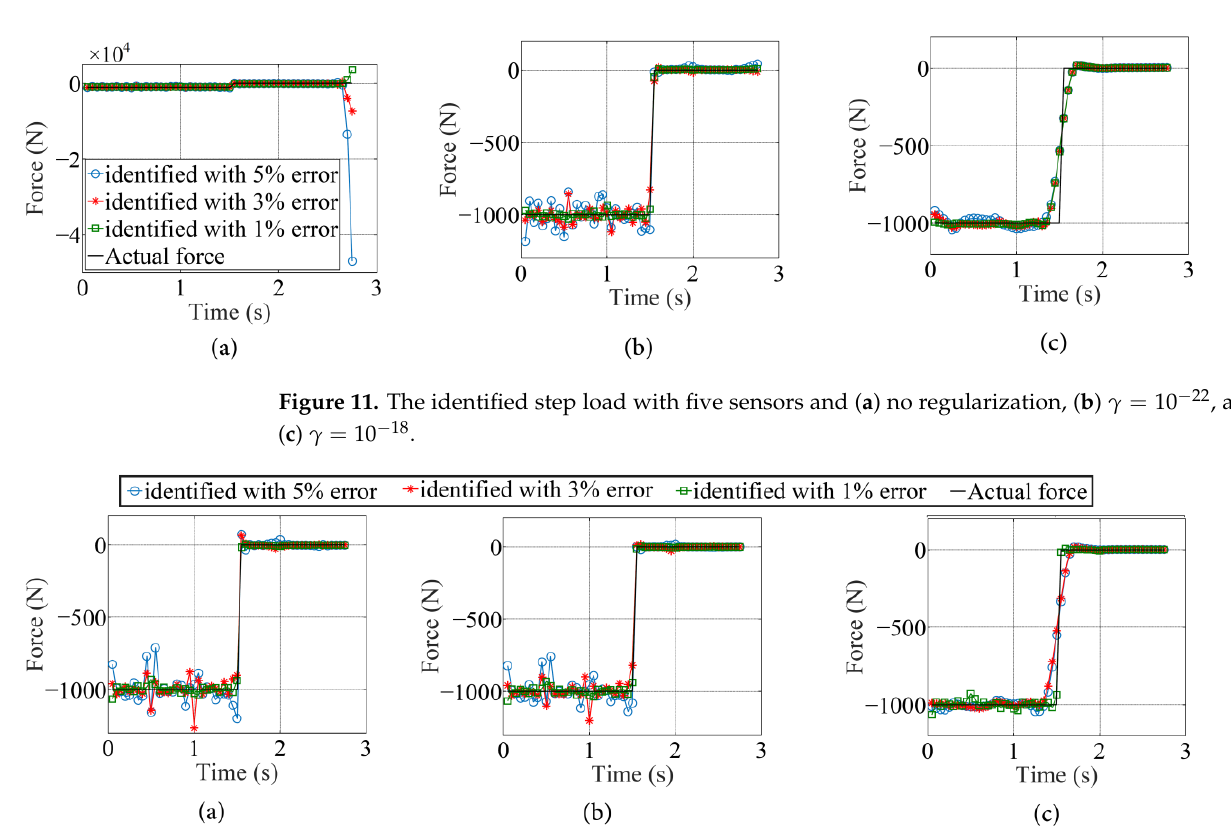
Figure 12. The identified step load with six sensors and ( a ) no regularization, ( b ) γ = 10 − 22 , and ( c ) γ = 10 − 18 .